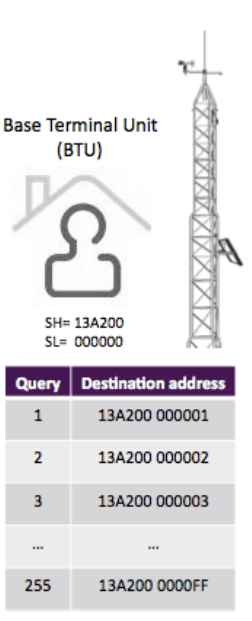
Figure 3. Example of destination and source parameters in wireless communication between remote and base